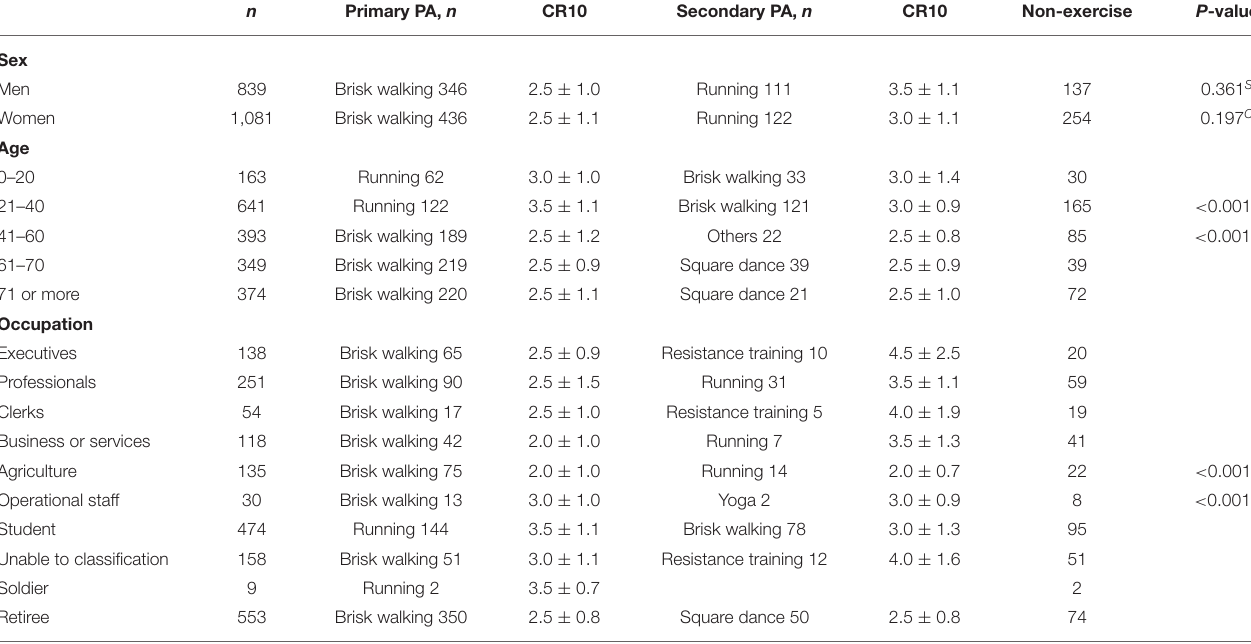
TABLE 1 | Participant characteristics of reported regarding primary and secondary physical activity (PA) forms, CR10, and nonexercise